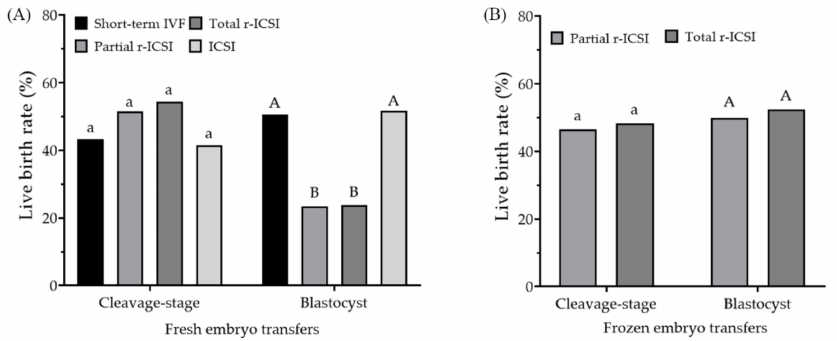
Figure 2. ( A ) Comparison of live birth rates per fresh embryo transfers from cleavage-stage and blastocyst transfers among the four groups. ( B ) Comparison of live birth rates per frozen embryo transfers from r-ICSI derived cleavage-stage and blastocyst transfers. Bars with different letters differ significantly among groups ( p <